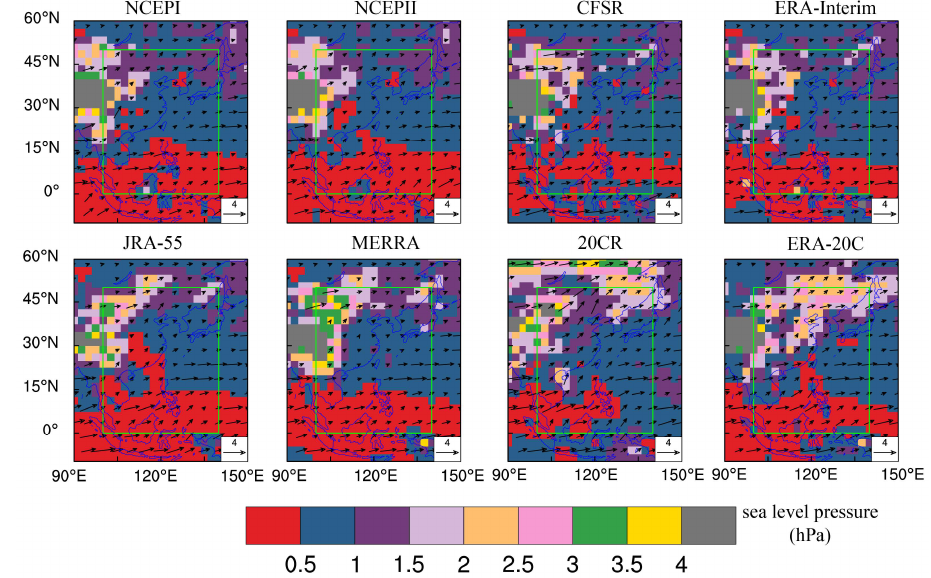
Figure 7. As in Figure 6, but for mean sea level pressure (SLP; shaded) and lower level winds (at 850 hPa; vector). The reference data for mean sea level pressure is the extended Hadley Centre monthly historical mean sea level pressure dataset (HadSLPr2). The Integrated Global Radiosonde Archive (IGRA) is selected to evaluate the winds. The green box is the East Asian summer monsoon region (0–50° N, 100–140° E).